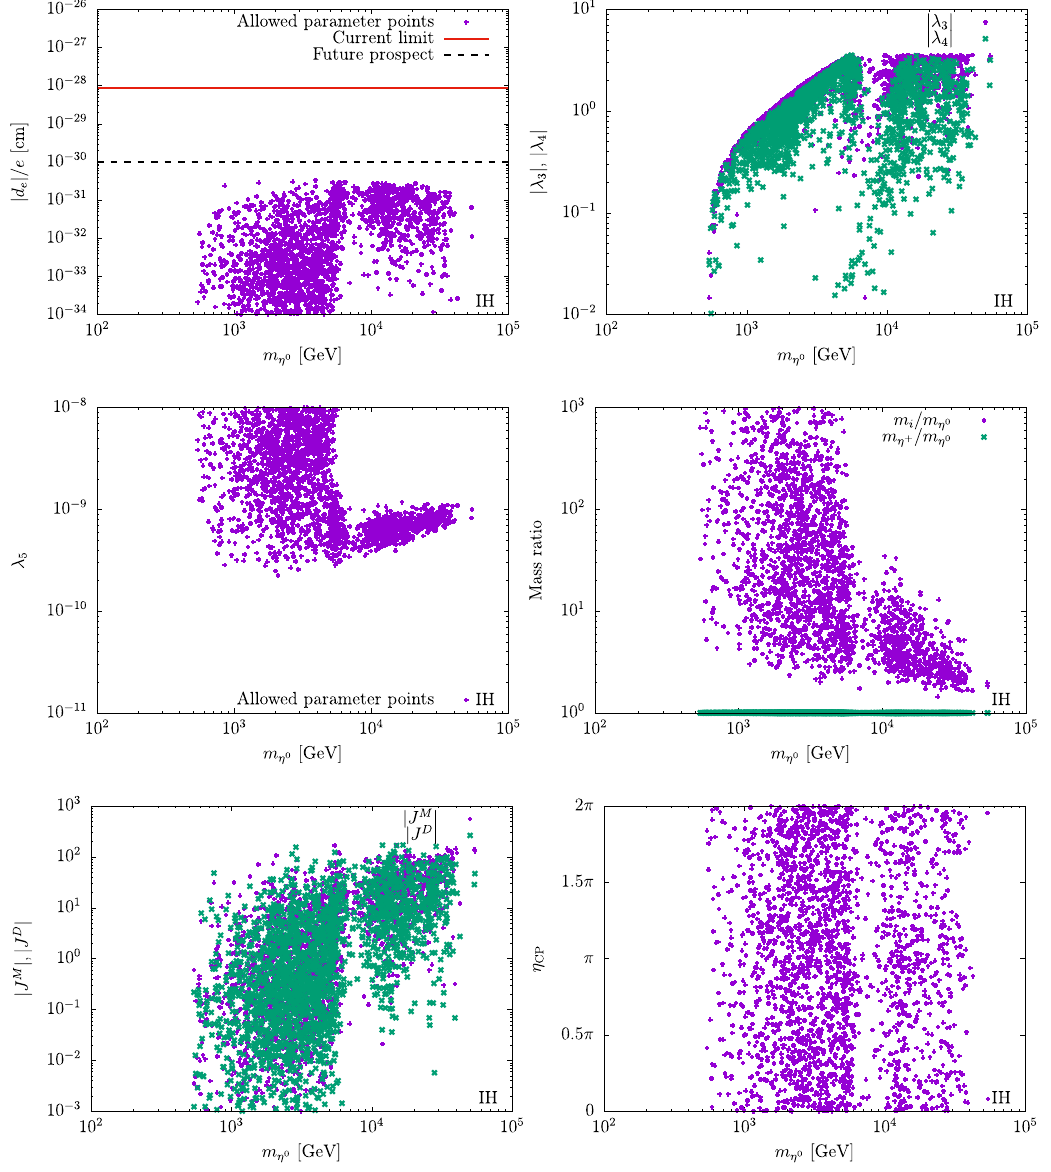
Figure 7 . Numerical results for scalar dark matter in the case of inverted hierarchy for the light neutrino mass spectrum. Each point complies with all the constraints discussed in section